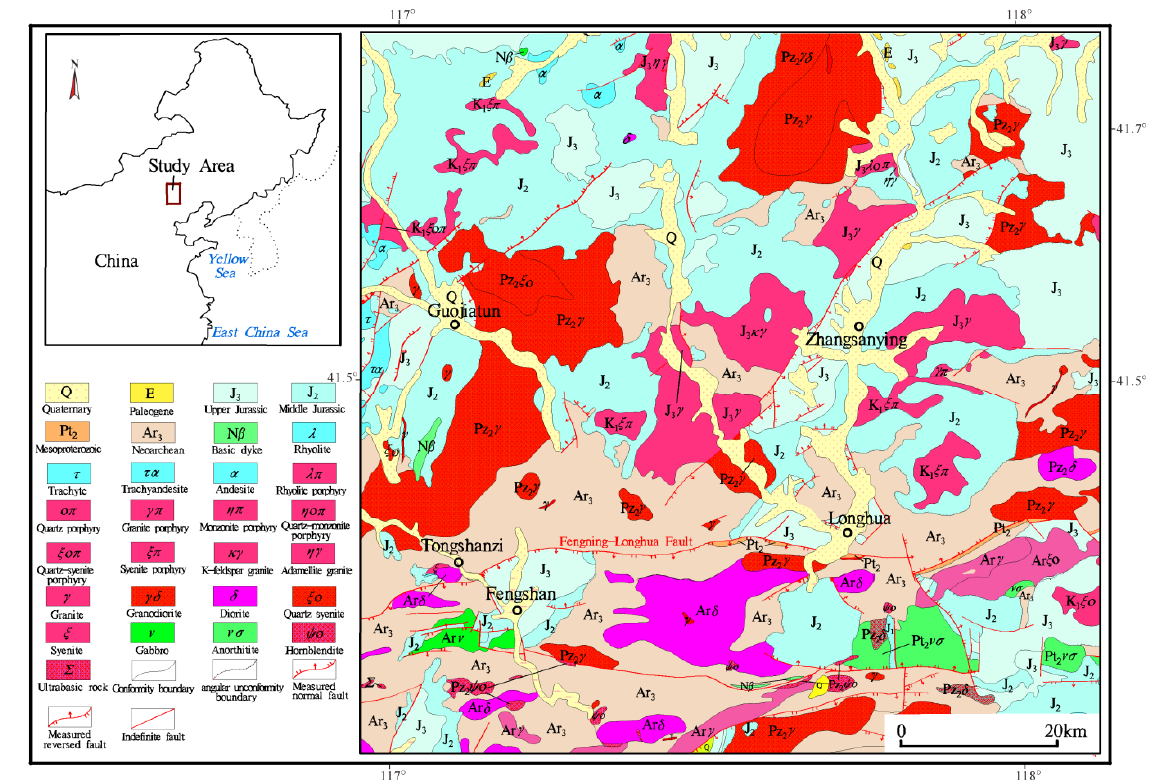
Figure 1. Geological map of the study region.